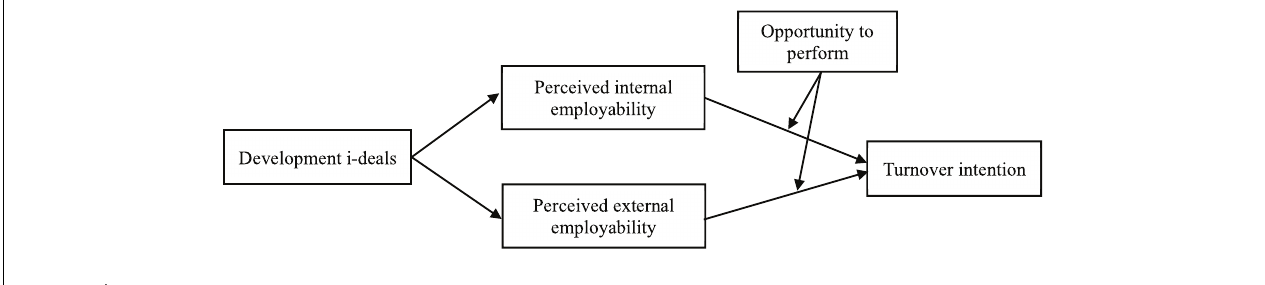
FIGURE 1 | Theoretical